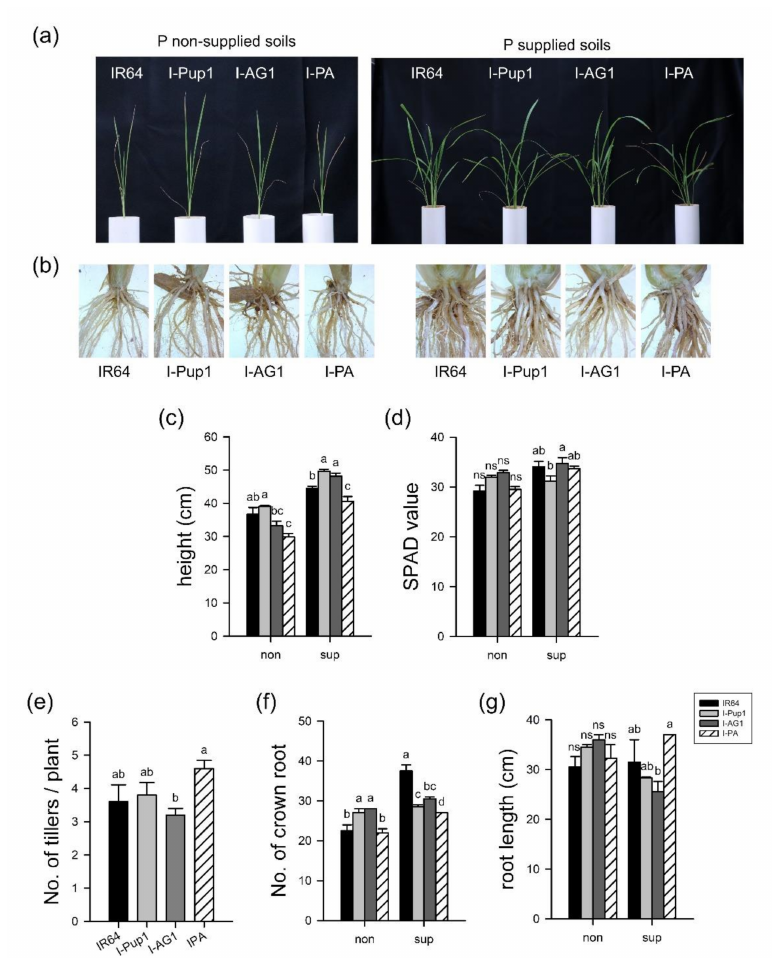
Figure 2. Phenotypic analysis of IR64, I-Pup1, I-AG1, and I-PA under di ff erent phosphorous conditions. ( a , b ) Phenotype of plants that were grown under P non-supplied and P-supplied conditions, respectively. ( c , d ) Plant height and SPAD value. ( e ) Tiller numbers per plant under P-supplied condition. ( f , g ) Crown root number per plant, root length. I-Pup1: IR64-Pup1; I-AG1: IR64-AG1; IPA: IR64-Pup1-AG1. The letters above bars represent statistical significance ( p < 0.01) as measured by Duncan’s multiple range test. ns: no significant di ff erence.